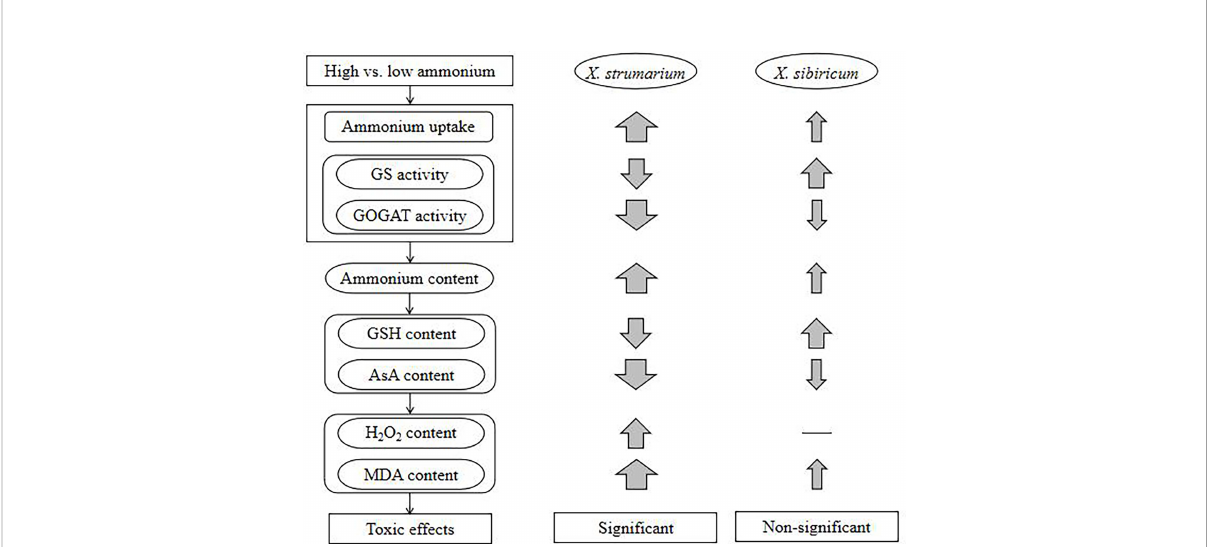
FIGURE 6 A schematic diagram showing the effects of high ammonium concentration on the invasive plant Xanthium strumarium and its native congener X. sibiricum . GS, glutamine synthetase; GOGAT, glutamate synthase; GSH, reduced glutathione; AsA, reduced ascorbic acid; H peroxide; MDA, malondialdehyde. Up arrows, increase; down arrows, decrease; thickness of the arrow indicates the degree of increase or decrease; — , not